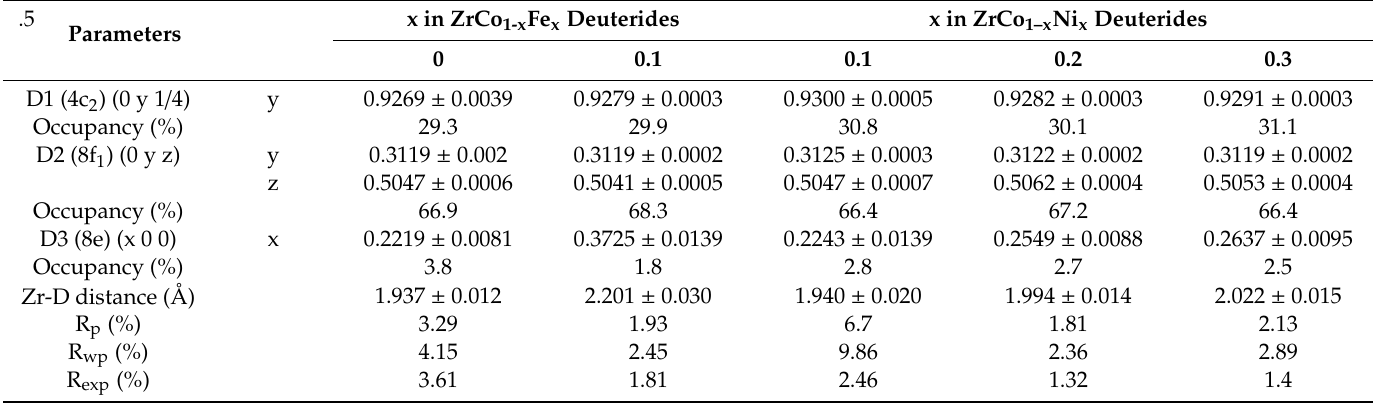
Table 2. Rietveld optimization results for neutron di ff raction data of ZrCo 1–x Fe x and ZrCo 1–x Ni x hydride